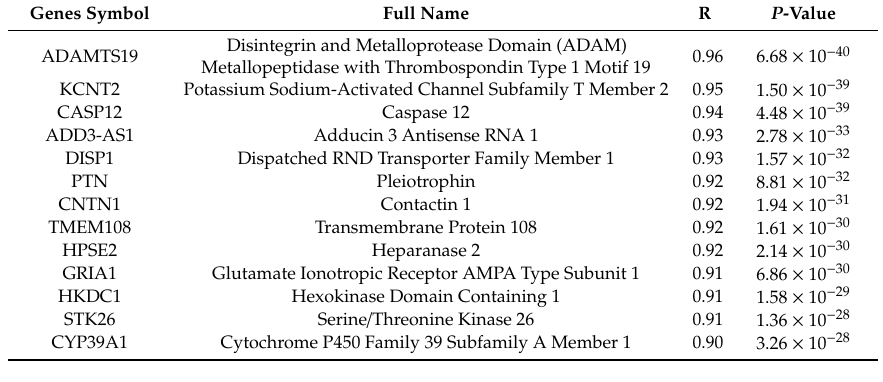
Table 1. Candidate hub genes in the yellow module. Genes with a correlation (R) > 0.9 were candidate hub genes.